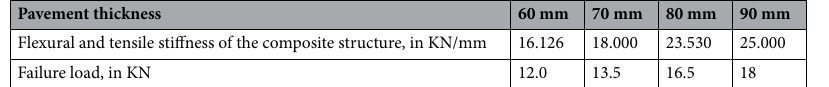
Pavement thickness Flexural and tensile stiffness of the composite structure, in